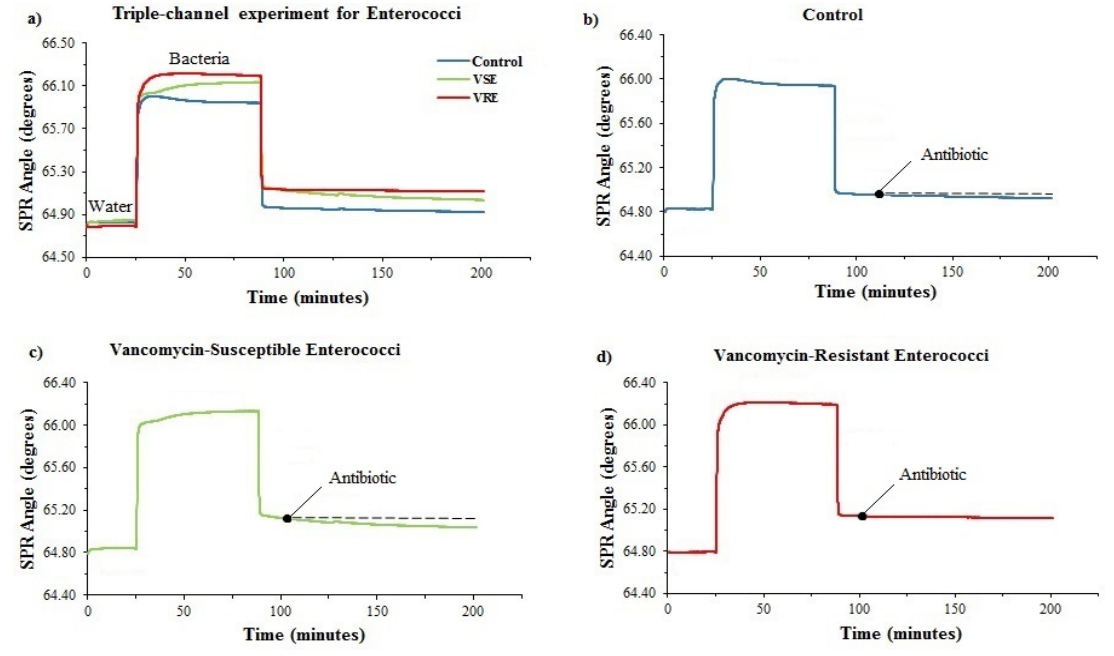
Figure 6. ( a ) Real-time SPR kinetic curve for antibiotic-resistant and susceptible enterococci against vancomycin treatment on the 3-channel system. ( b ) Control sample, E. coli . ( c ) Vancomycin-susceptible enterococci (strain VSE 8). ( d ) Vancomycin-resistant enterococci (strain VRE 2).